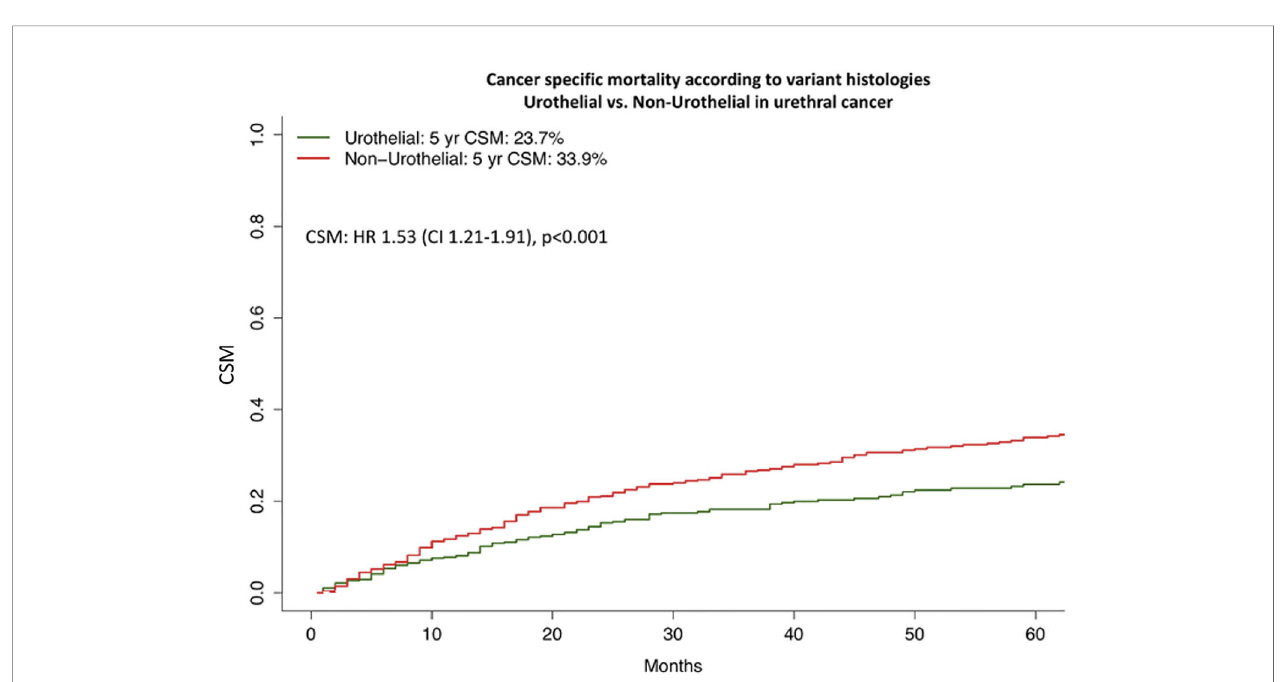
FIGURE 2 | Cancer speci fi c mortality of urothelial vs. non-urothelial histology in urethral cancer. Cumulative incidence plots illustrating cancer speci fi c mortality (CSM) after 1:1 propensity score matching for TNM-stage and age at diagnoses in urothelial vs. non-urothelial histology urethral cancer patients (both n = 765). HR, Hazard Ratio; CI, Con fi dence Interval.